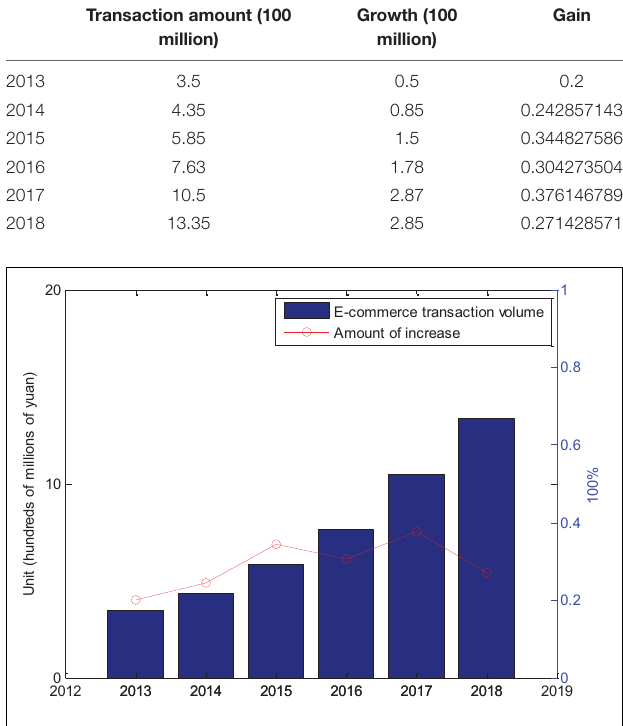
FIGURE 4 | Trends in the scale of China’s e-commerce